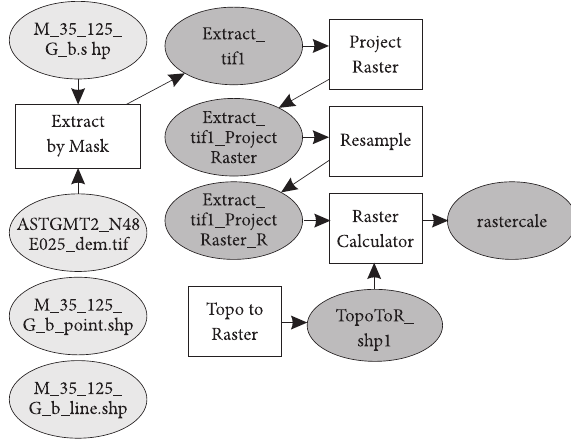
Fig. 3. ArcGIS geoprocessing model for the elevation